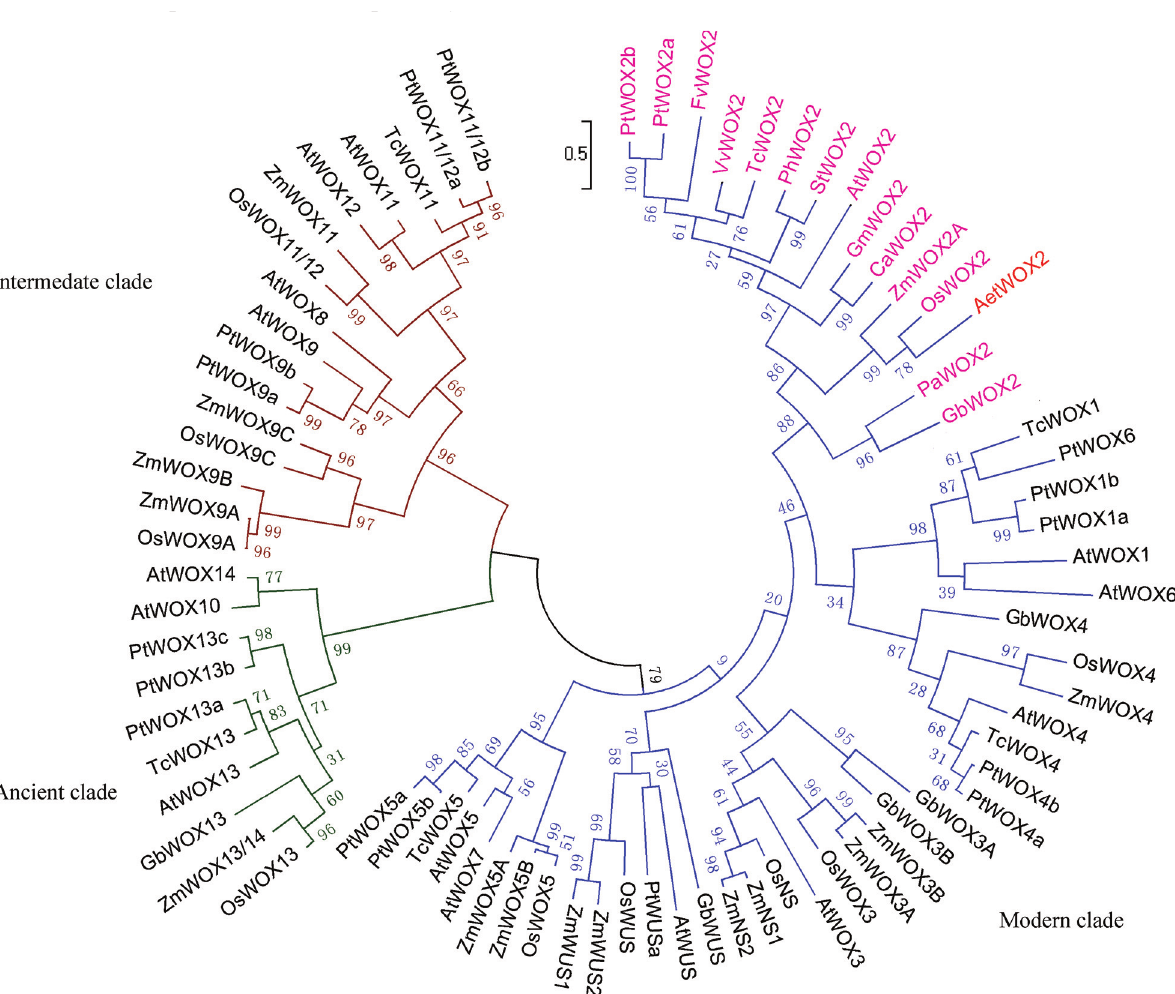
Figure 4 - Phylogenetic analysis of plant WUS/WOX proteins based on the Maximum Likelihood method. Abbreviations are P. tomentosa, Pt; and T. ca- cao, Tc. The three clades are color-coded, WUS/WOX1-7 (modern) in blue, WOX8, 9, 11, 12 (intermediate) in brown and WOX10, 13, 14 (ancient) in green. Protein names of the WOX2 subclade are in purple and AetWOX2 is